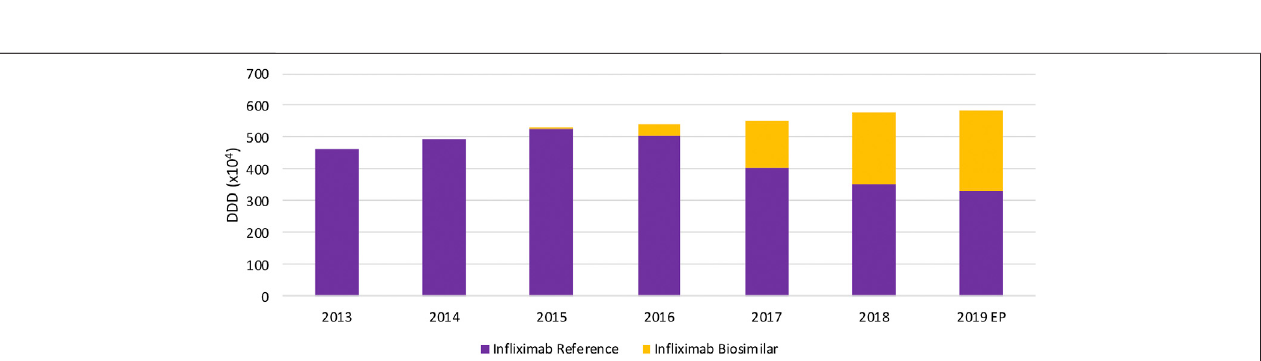
FIGURE 3 | Total volume (DDD) evolution of IV TNF inhibitors between 2013 and 2019. EP: Extrapolated data.